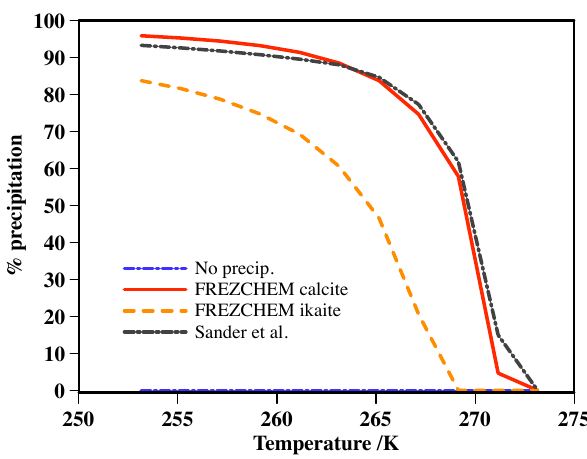
Fig. 1. Precipitation of calcium carbonate during the freezing of sea water.